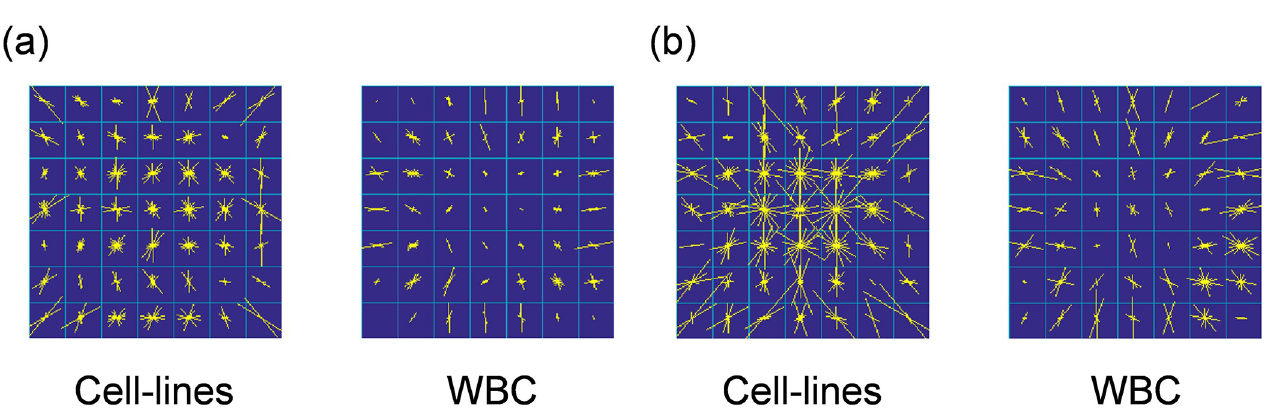
Fig 11. Weight vectors of SVM classifier found by parameter search visualized in seven-by-seven compartments. The angles and lengths of the yellow lines in each cell represent direction and strength of decline in an QPM image. (a) Weight vectors of QPM images (OPL) normalized by path length. Left side represents visualized weight vectors of HOG feature of cell lines. Right side represents vectors of WBCs. (b) Weight vectors of QPM images (OPL) normalized by diameter. In each panel, the left sides represent weight vectors of HOG feature of cell lines. The right sides represent the vectors of WBCs.